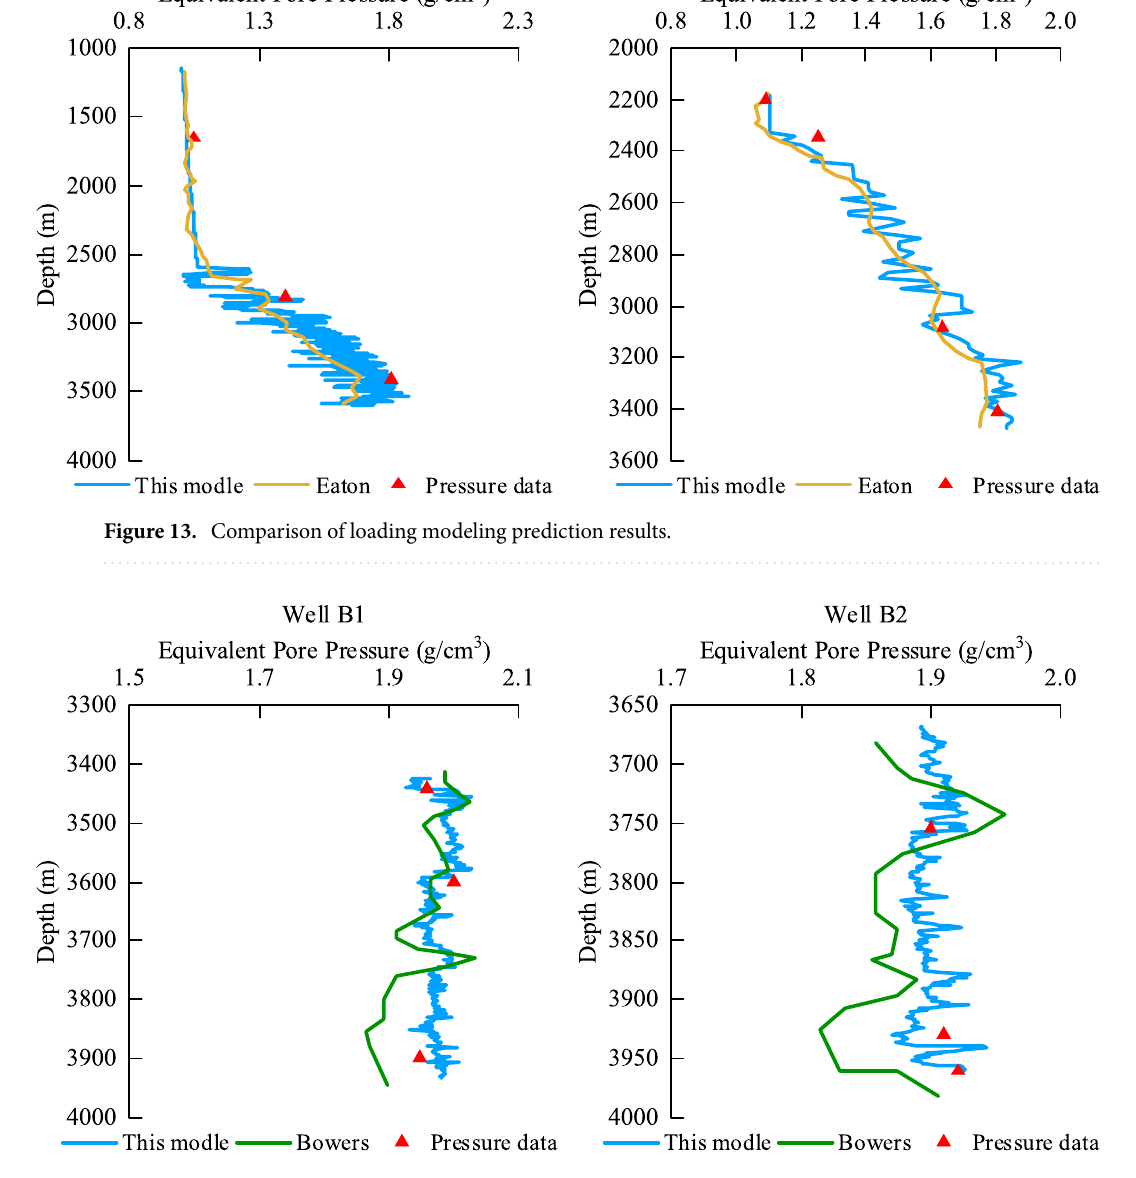
Figure 14. Comparison of unloading modeling prediction